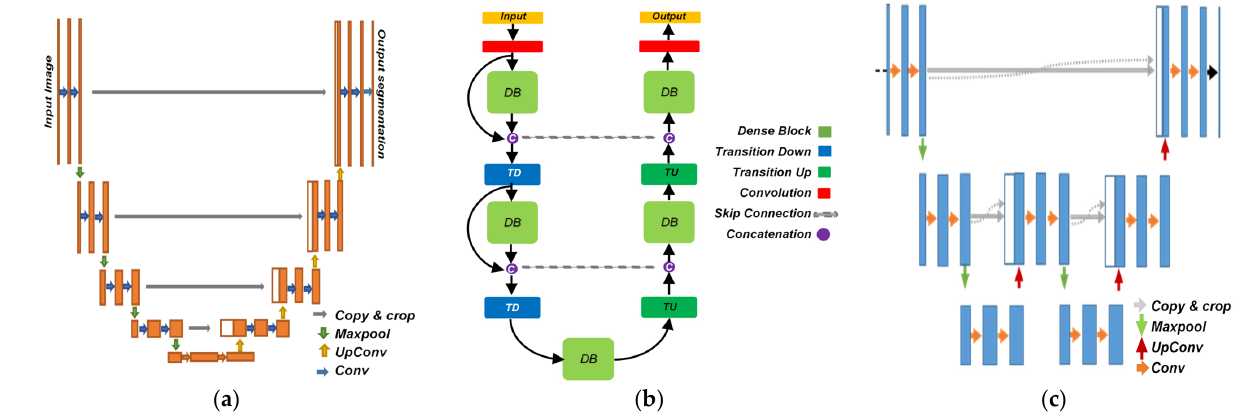
Figure 1. Graphical comparison between ( a ) U ‐ Net [19], ( b ) fully convolutional DenseNet [17], and ( c ) proposed AID ‐ U ‐ Net.